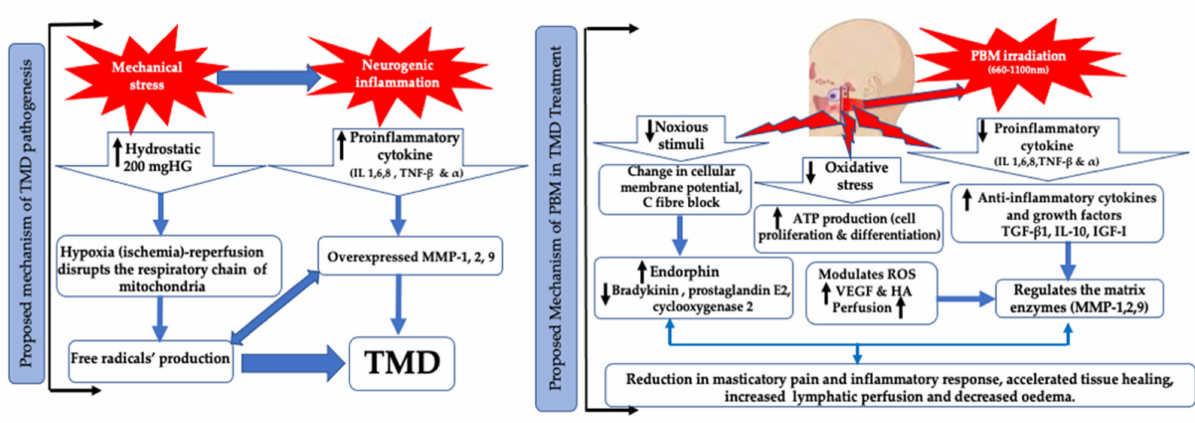
Figure 1. Schematic representation of the proposed aetiopathology mechanism of TMD and PBM mechanism of action in TMD management. Abbreviations: IL: Interleukin; TNF- β & α : transforming necrosis factor-beta and alpha; ROS: reactive oxygen species; ATP: adenosine triphosphate; MMP-1,2,9: matrix metalloproteinases-1,2,9; VEGF: vascular endothelial growth factor; HA: hyaluronic acid. All the abbreviations in this table are listed in Supplementary File